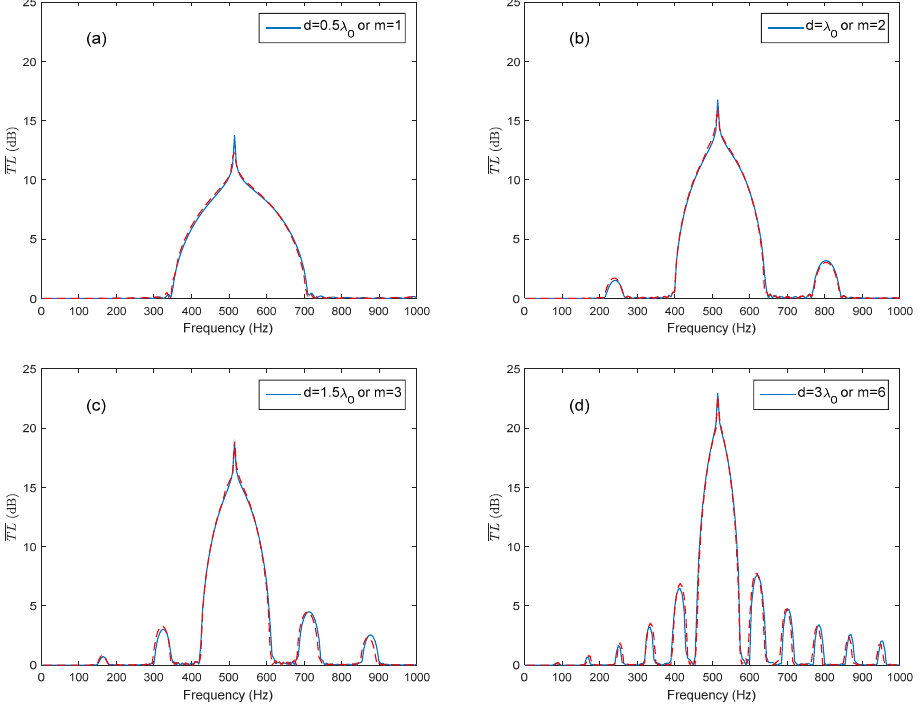
Figure 6. Comparison of theoretical predictions and the FEM simulation in respect of different periodic distances (solid lines represent the theoretical predictions, and dashed lines represent the FEM simulation results): ( a ) periodic distance d = λ 0 /2; ( b ) periodic distance d = λ 0 ; ( c ) periodic distance d = 1.5 λ 0 ; ( d ) periodic distance d = 3 λ 0